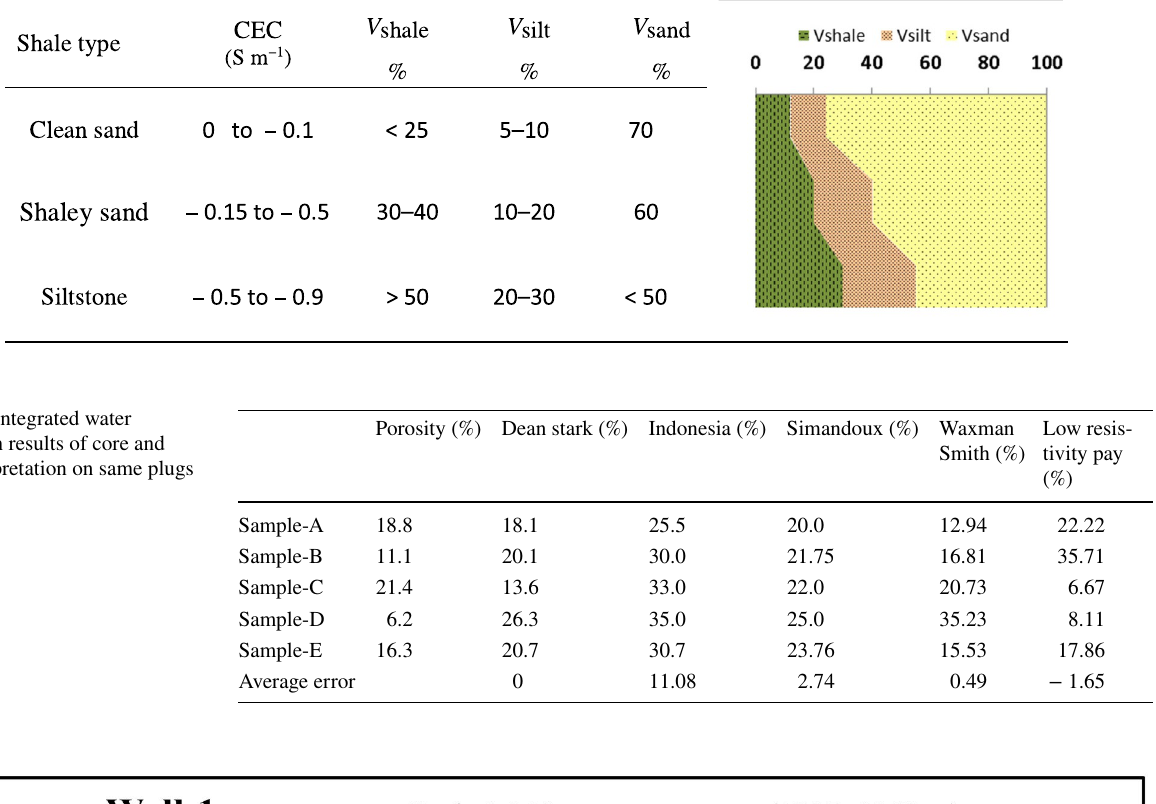
Table 6 Cation exchange capacity integrated characterization